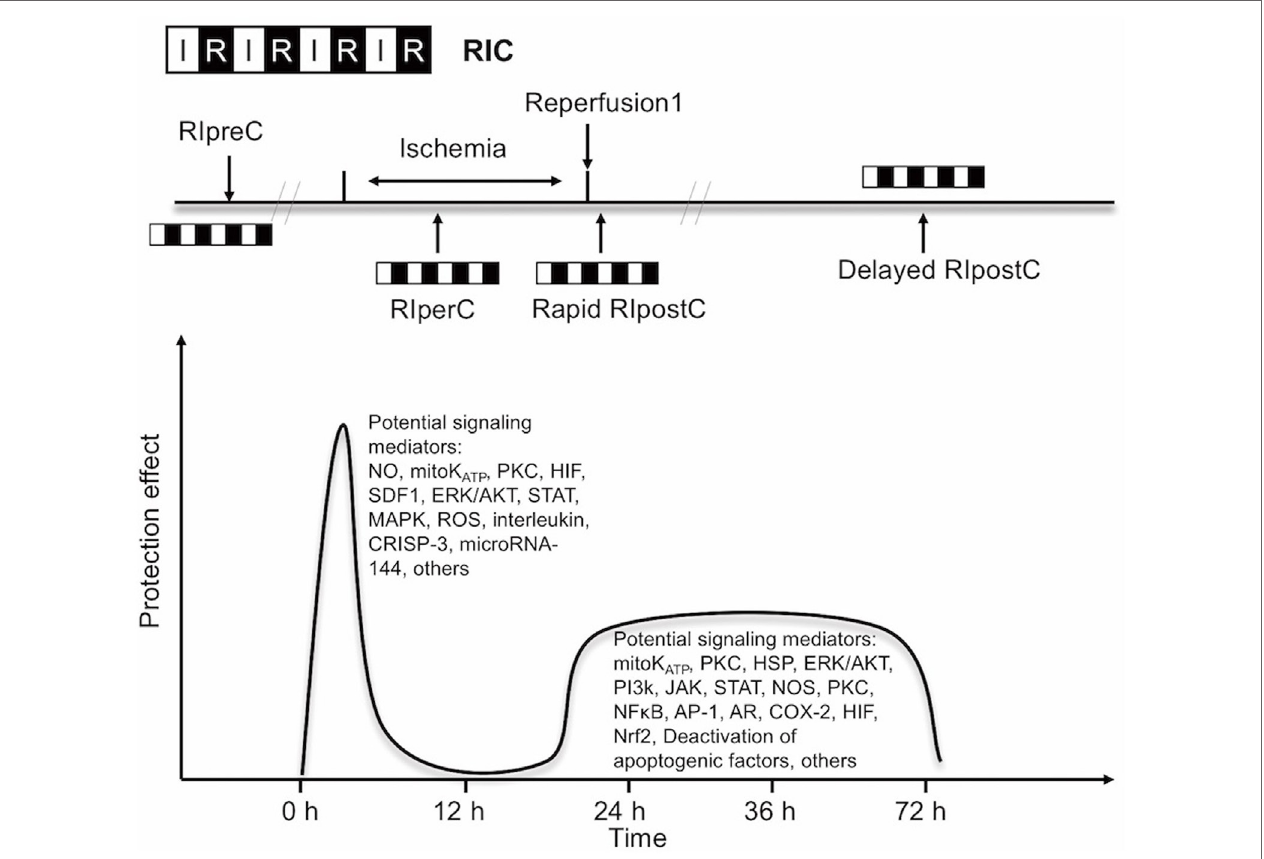
FigURe 1 | Simplified scheme and possible mechanisms of the temporal nature of the two windows of remote ischemic conditioning (RIC). Abbreviations: AR, aldose reductase; AP-1, activator protein 1; COX-2, cyclooxygenase-2; CRISP-3, cysteine-rich secretory protein 3; NOS, nitric oxide synthase; ERK/AKT, extracellular signal regulated kinase/protein kinase B; HIF, hypoxia-inducible factor; HSP, heat shock protein; JAK, Janus kinase; K ATP , ATP-sensitive potassium channel; MAPK, mitogen-activated protein kinase; Mito, mitochondria; NF κ B, nuclear factor κ B; NO, nitric oxide; Nrf2, nuclear factor erythroid 2-related factor; PI3k, phosphoinositide-3 kinase; PKC, protein kinase C; ROS, reactive oxygen species; SDF1, stromal cell-derived factor 1; STAT, signal transducer and activator of